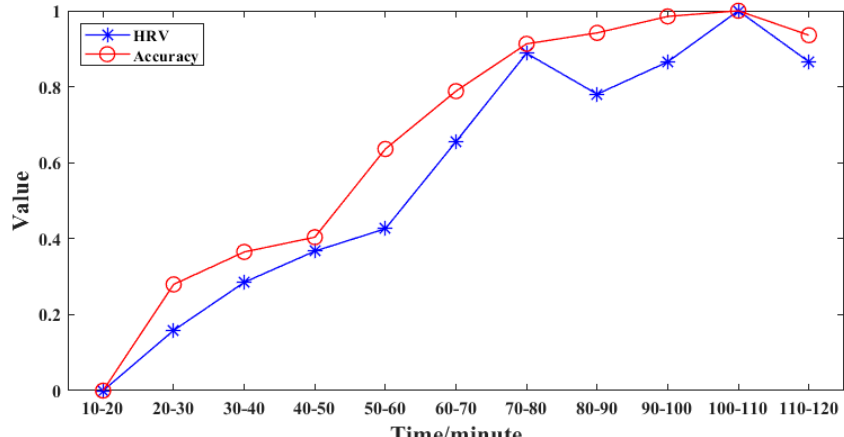
Figure 4. The correlation between the HRV and accuracy. As for the line of HRV shown in the figure,